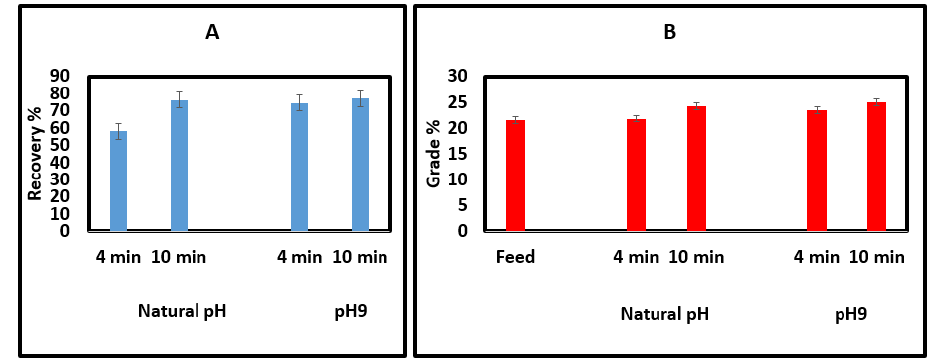
Figure 9. ( A ) Flotation recovery and ( B ) P 2 O 5 grade (%) of concentrate products obtained from baseline experiments.